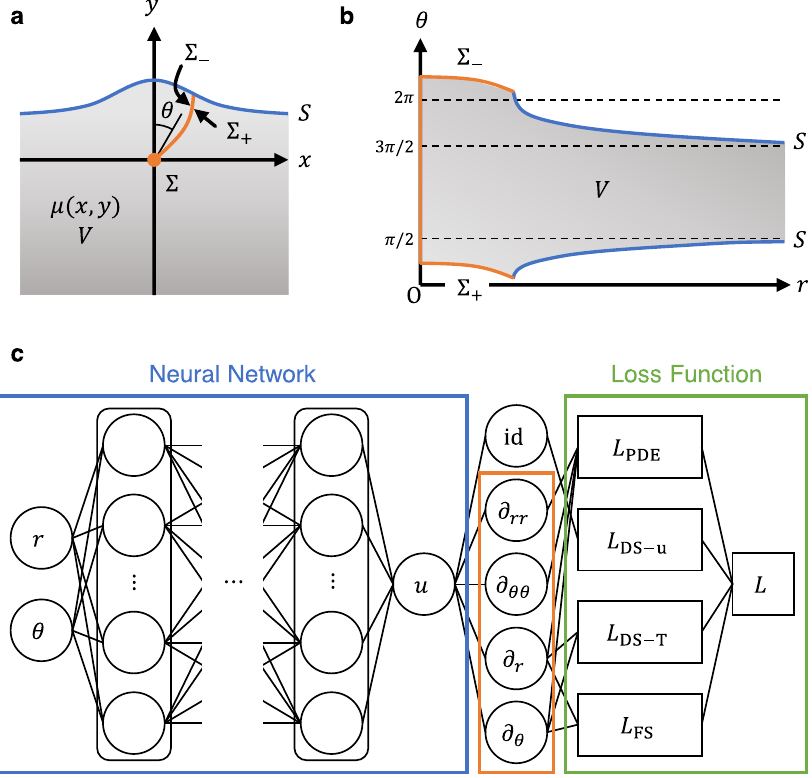
Fig. 1 | Physics-informed neural network (PINN) modeling of antiplane dis- of Σ . Thefaultmovesperpendiculartothepage. b Polarcoordinaterepresentation locations. a Cross-sectional view of an in fi nitely long strike-slip fault model. Sha- of the modelregion. c PINN structure.Aneuralnetworksurrogates adisplacement u(r, θ ) in the polar coordinates. Derivatives of u are calculated using automatic dedregion,orangeline,andbluelinerepresentelasticmedium V ofshearmodulus μ (x, y) , fault Σ , and Earth ’ s surface S , respectively. Σ Σ − representthe two sides differentiation and constitute a loss function L + and